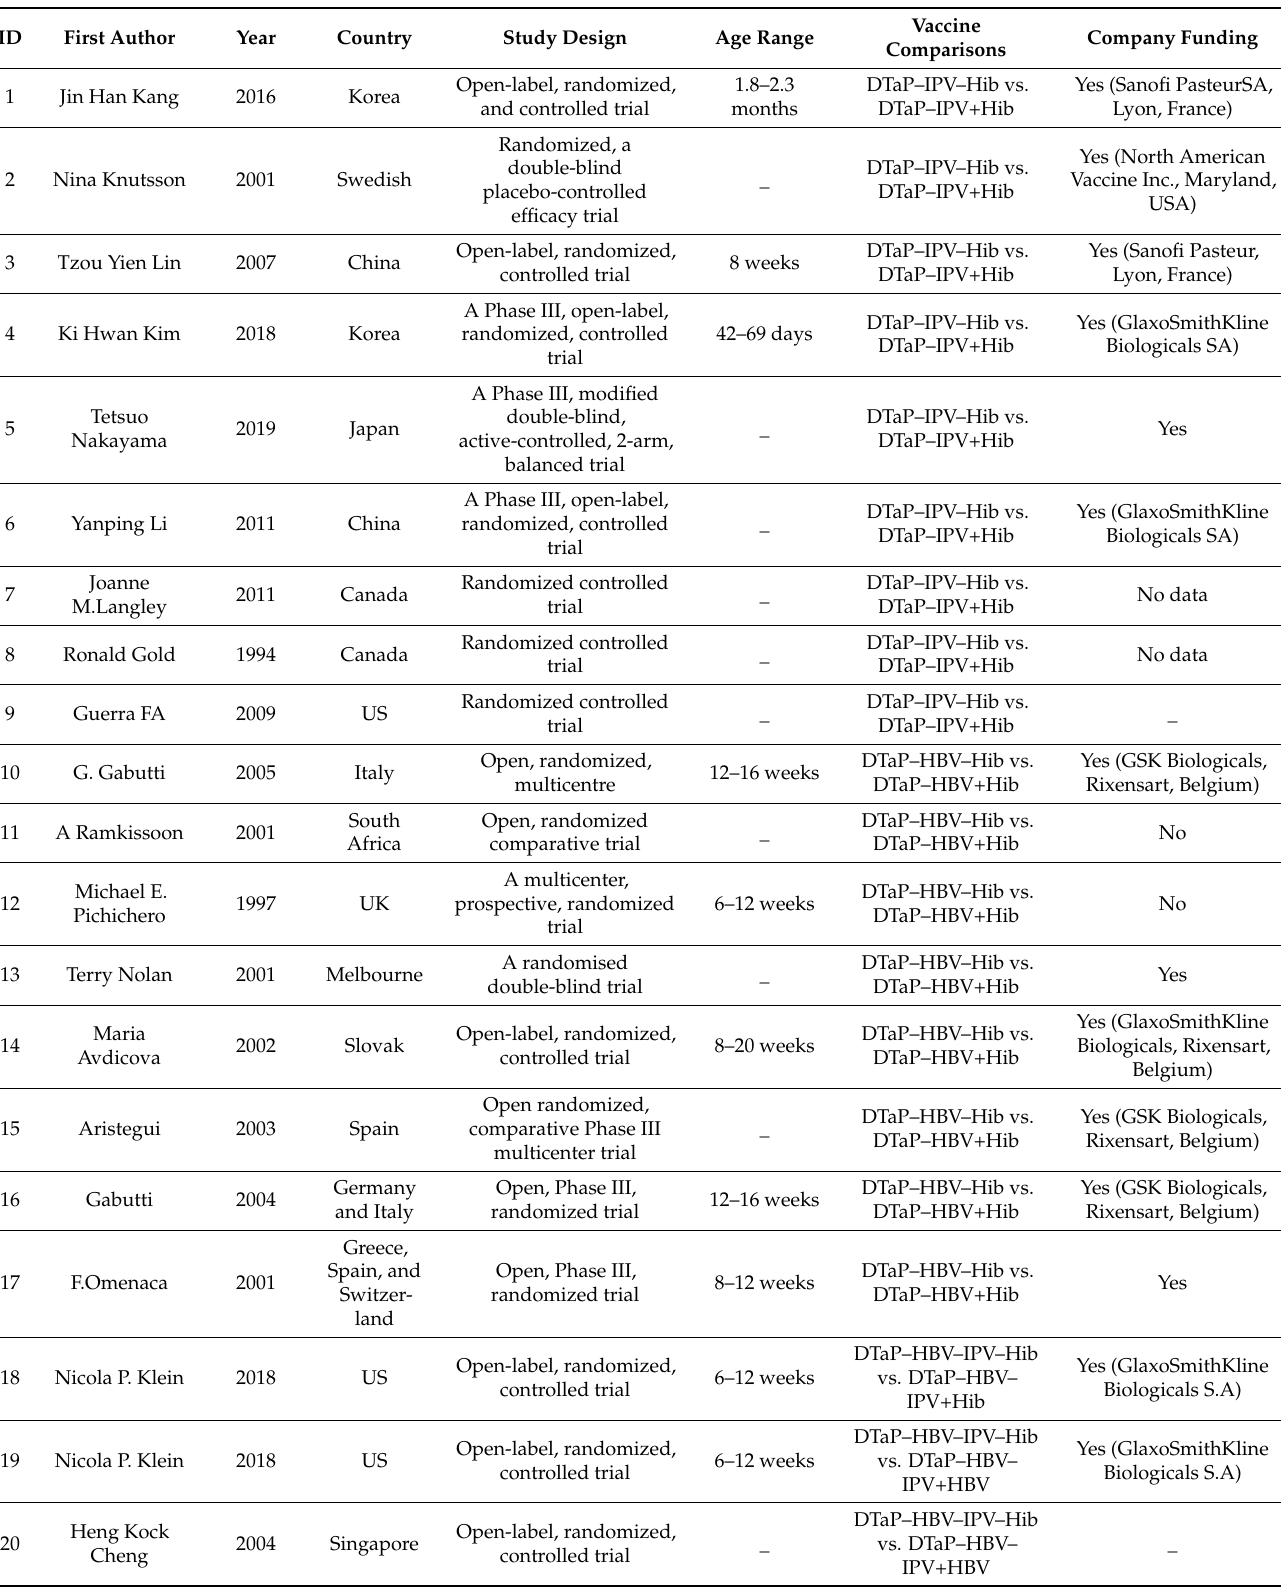
Table 1. Basic Characteristics of included